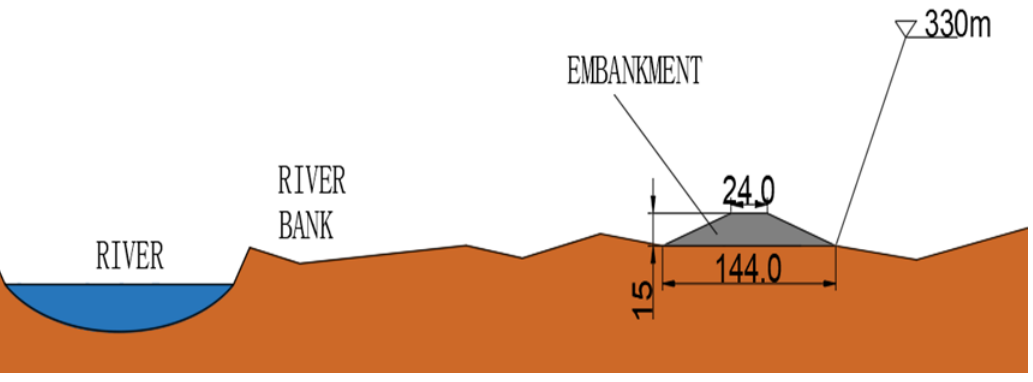
Figure 5. Vertical transport reservoir section.